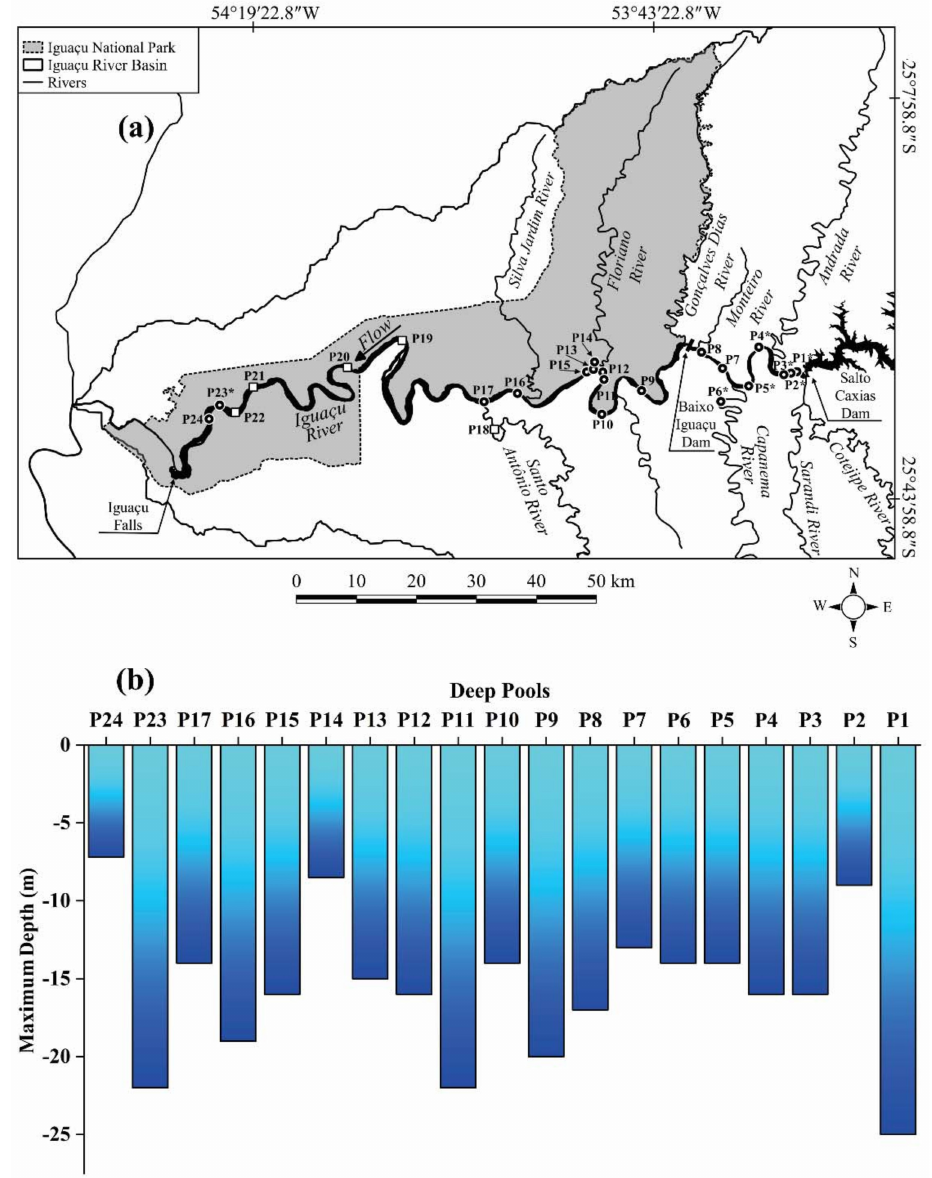
Figure 4. Locations of deep pools ( a ) and their maximum depths ( b ) in the Lower Iguaçu River, downstream of the Salto Caxias Dam, upstream of the Iguaçu Falls. Iguaçu National Park (INP) is highlighted in gray. (cid:3) : deep pools indicated by ICMBio. Asterisks (*) indicate where the bathymetry was performed to characterize the deep